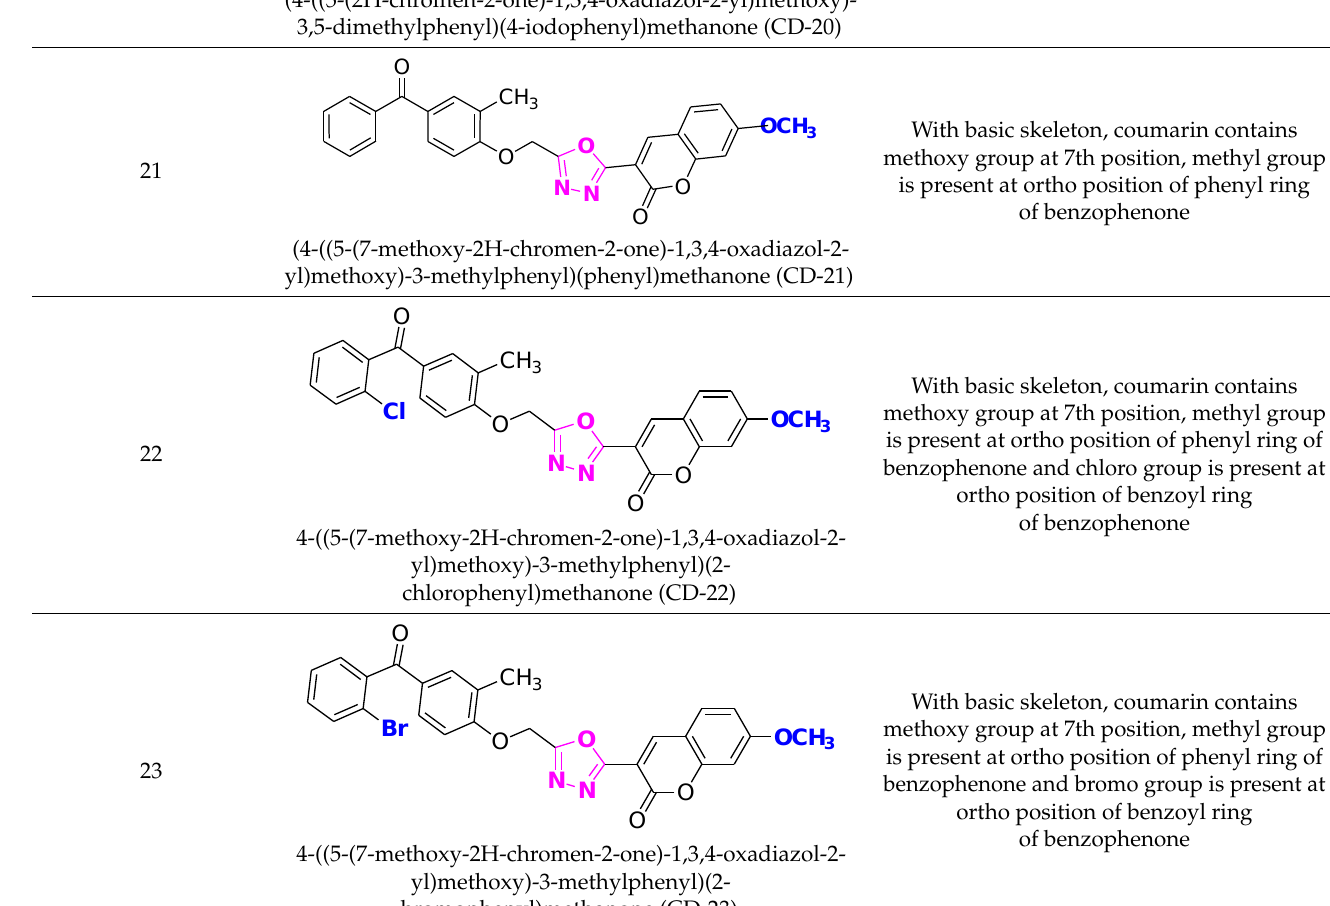
With basic skeleton, coumarin contains methoxy group at 7th position, methyl group is present at ortho position of phenyl ring of benzophenone and bromo group is present at ortho position of